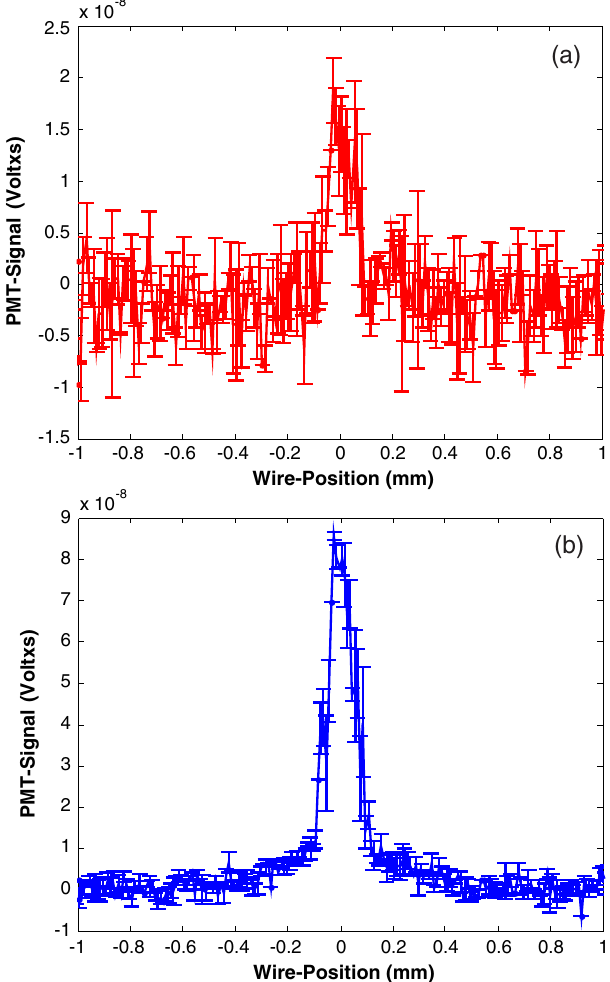
FIG. 10. Vertical profiles of the electron beam — energy 245 MeV and charge 180 pC — resulting from the projection of an OTR image and from a WSC measurement of the beam: sigma ð OTR ; rms Þ ¼ ð 0 . 308 (cid:2) 0 . 008 Þ mm, sigma ð WSC ; rms Þ ¼ ð 0 . 304 (cid:2) 0 . 014 Þ mm. Motor-speed 0 . 2 mm = s.